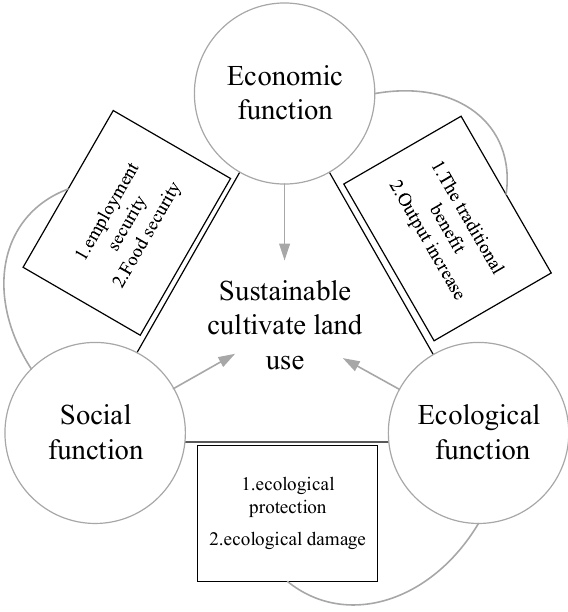
Figure 2. A classification framework for the functions of cultivated land.